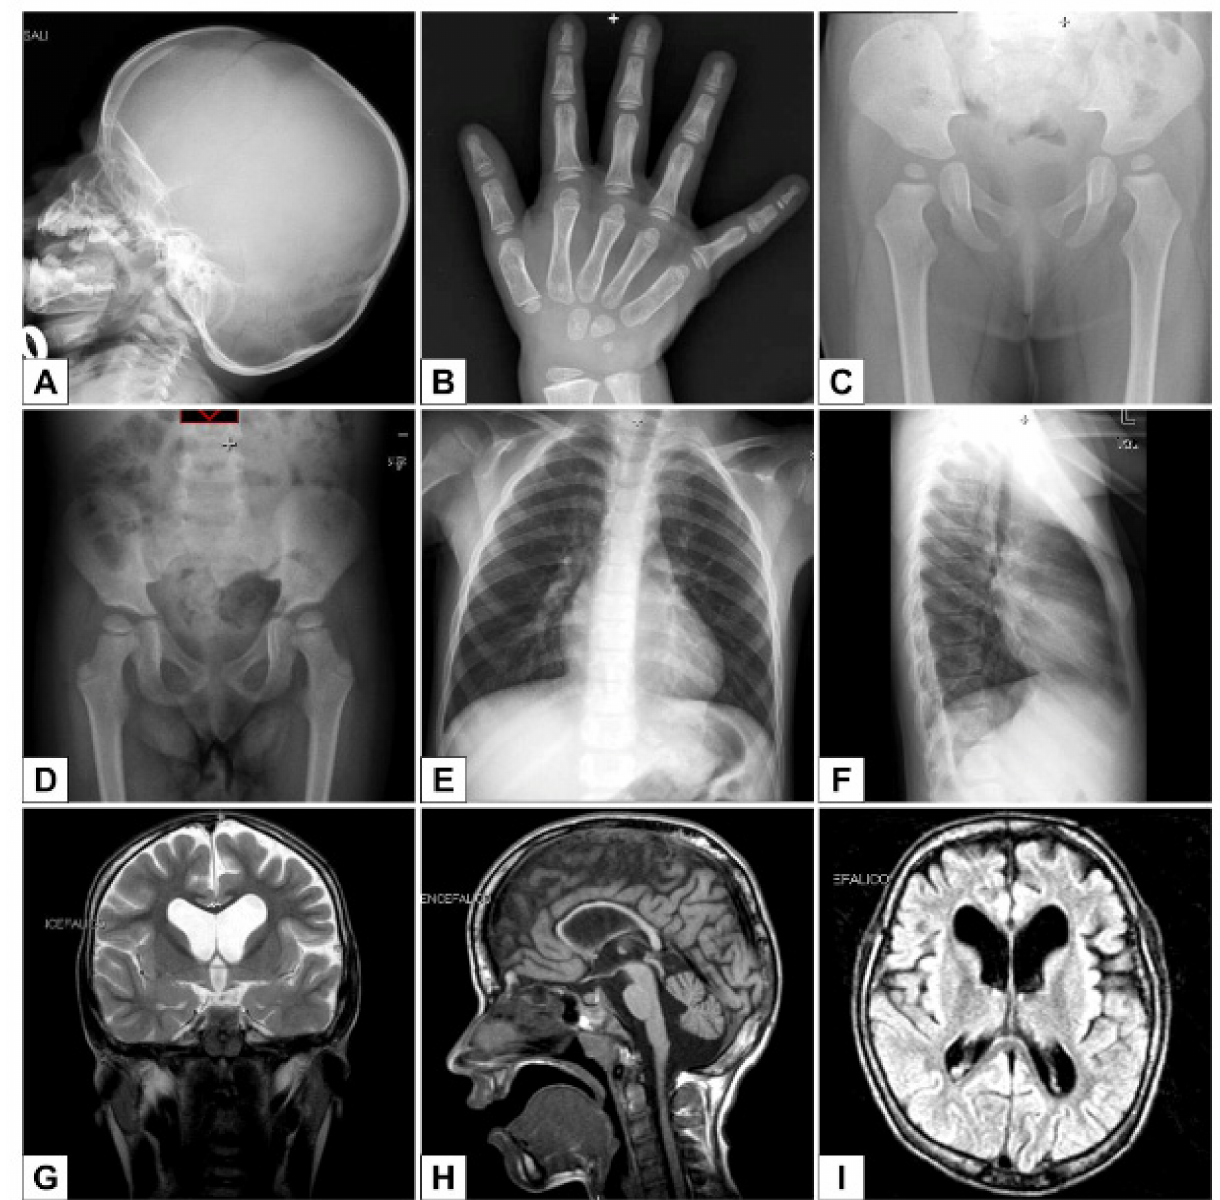
Figure 2. ( A ) Skull X-ray: large fontanel and Wormian bones; ( B ) Hand X-ray: delayed bone age. According to Greulich and Pyle Atlas at a chronological age of 4 years and 9 months, her bone age was consistent with an age of 2 years and 5 months; ( C , D ) Hip X-rays at 1 and 6 years: hip dysplasia; ( E , F ) Spine X-rays: scoliosis and mild thoracic kyphosis; ( G – I ) Brain MRI; ( G ) Coronal DWI image: large frontal horns of the lateral ventricles; ( H ) Sagittal T1 image: cerebellar atrophy and thin corpus callosum; ( I ) Axial FLAIR image: frontal lobes atrophy and large frontal horns of the lateral